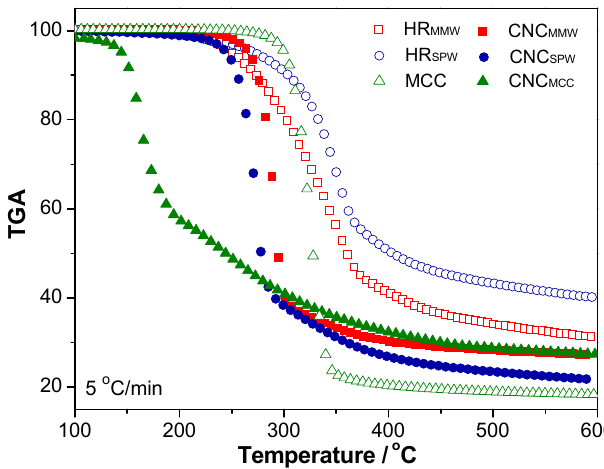
Figure 6. Thermogravimetric curves of the hydrolyzed residuals, MCC and the resulted